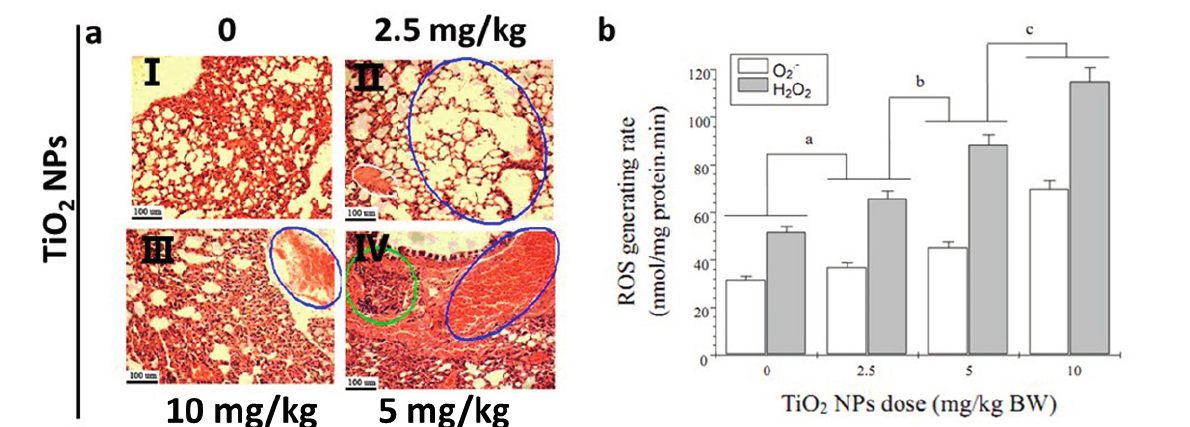
Figure 3. ( a ) Histopathological observation caused by an intratracheal instillation with TiO 2 NPs for 90 consecutive days from different groups. (I–IV) 2.5 mg/kg TiO 2 NPs group presents pulmonary emphysema (blue cycle) and edema (white cycle) (II). 10 mg/kg TiO 2 NPs group indicates pulmonary bleeding (blue cycle) (III). 5 mg/kg TiO 2 NPs group indicates inflammatory cell infiltration (green cycle) and congestion of blood vessel (blue arrow) (IV) [38]; ( b ) ROS accumulation of the mouse lung after an intratracheal instillation with TiO 2 NPs for 90 consecutive days. Treatments with different letters indicate significantly different values ( p < 0.05). Values represent means ± SE ( N = 5) [38]; ( c ) HE-staining (I–III), immunohistochemistry of FSP-1 (IV–VI) and Sirius Red staining (VII–IX) of lung tissues of SH rats exposed by intratracheal instillation to PBS, short or long MWCNTs for 30 days. Scale bar as follows: 100 μ m (I–III, VII–IX) and 50 μ m (IV–VI) [33]; ( d ) ELISA analysis of TGF- β 1 in BAL fluid of SH rats exposed by intratracheal instillation to PBS, short or long MWCNTs [33]; ( e ) AFM images of Bovine Fibrinogen (BFG), Gamma globulin (Ig), Tf (Transferrin) and BSA (Bovine serum albumin) after incubation with SWCNTs for 10 min ( A ) and 5 h ( B ). Molecular modeling illustrations for proteins (in beads representation) binding to SWCNTs after incubation for 10 min ( C ) and 5 h ( D ). ( E ) Locations of the most preferred binding sites on proteins for SWCNTs. Residues highlighted in van der Waals representation corresponding to tyrosine and phenylalanine. Tyrosine: red, phenylalanine: green, other parts of protein: transparent pink. ( F ) The detailed orientations of aromatic rings of tyrosine and phenylala nine residues interacted to six-member rings of SWCNTs (silver). The tyrosine residues (red) are rendered as licorice representation, and phenylalanine residues (green). ( G ) The far-UV CD spectra of proteins after incubation with SWCNTs and the insets are near-UV CD spectra of proteins incubated with SWCNTs [39]; ( f ) Quantitative analysis of Sprague Dawley rat lung cell DNA damage after whole-body exposure to MWCNTs using comet assay. The Sprague Dawley rats were exposed at 0, 0.16, 0.34, and 0.94 mg/m 3 for 1 month (* p < 0.05) [40]; ( g ) Mice were treated with graphene in 2% Pluronic F 108NF (Dispersed), aggregates of graphene in water (Aggregated) or GO in water by intratracheal instillation and 21 days later, the lungs were examined for markers of fibrosis. Photomicrographs of lung sections from different groups at 200× (I–III) and trichrome stained lung sections (IV–VI) [41]; ( h ) BALF levels of IL-6 from different groups ( * p < 0.05)